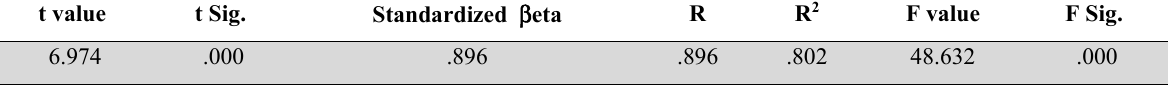
Results of simple linear regression to test the impact of ownership concentration effect on earnings per share (EPS) index value t Sig.